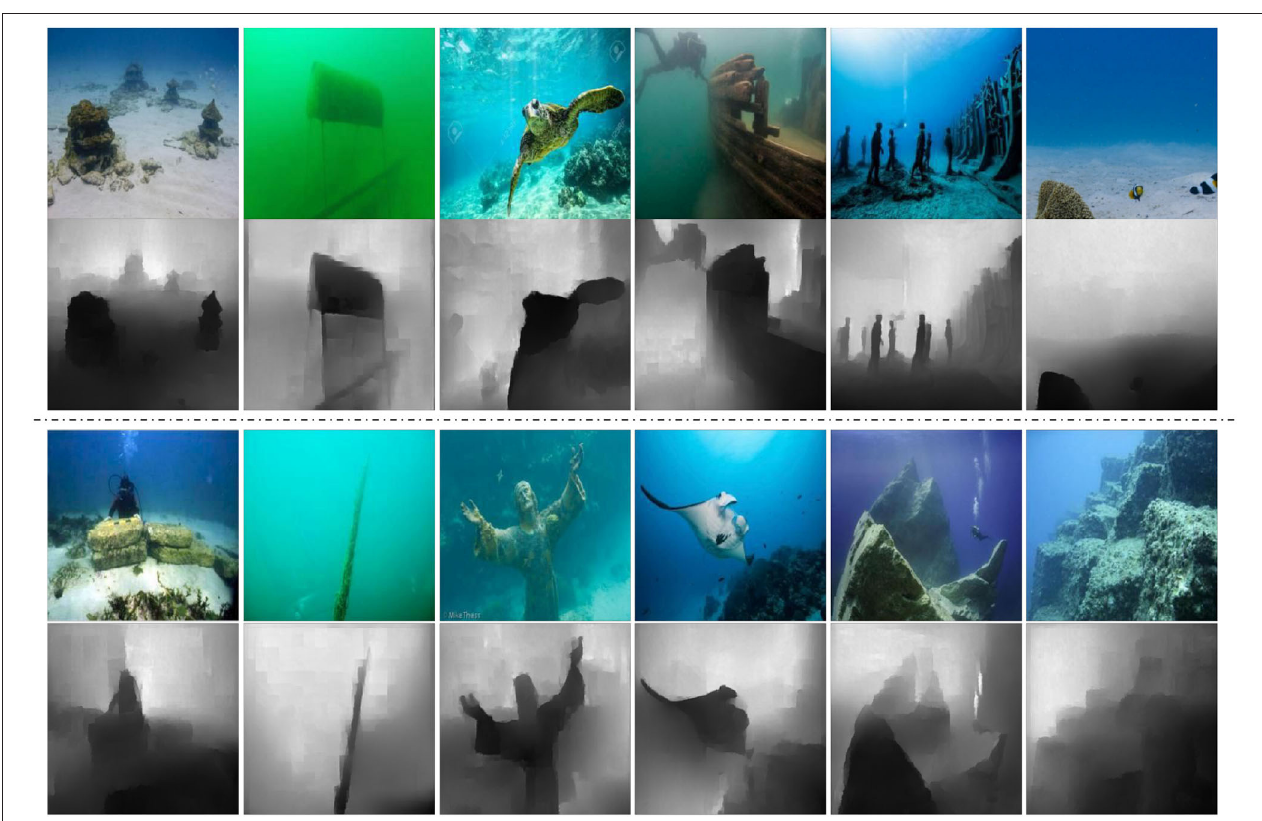
FIGURE 5 | The results of our model for depth map estimation. Every two rows from top to bottom are real underwater images with different illumination and scattering conditions and the results of our model for depth map